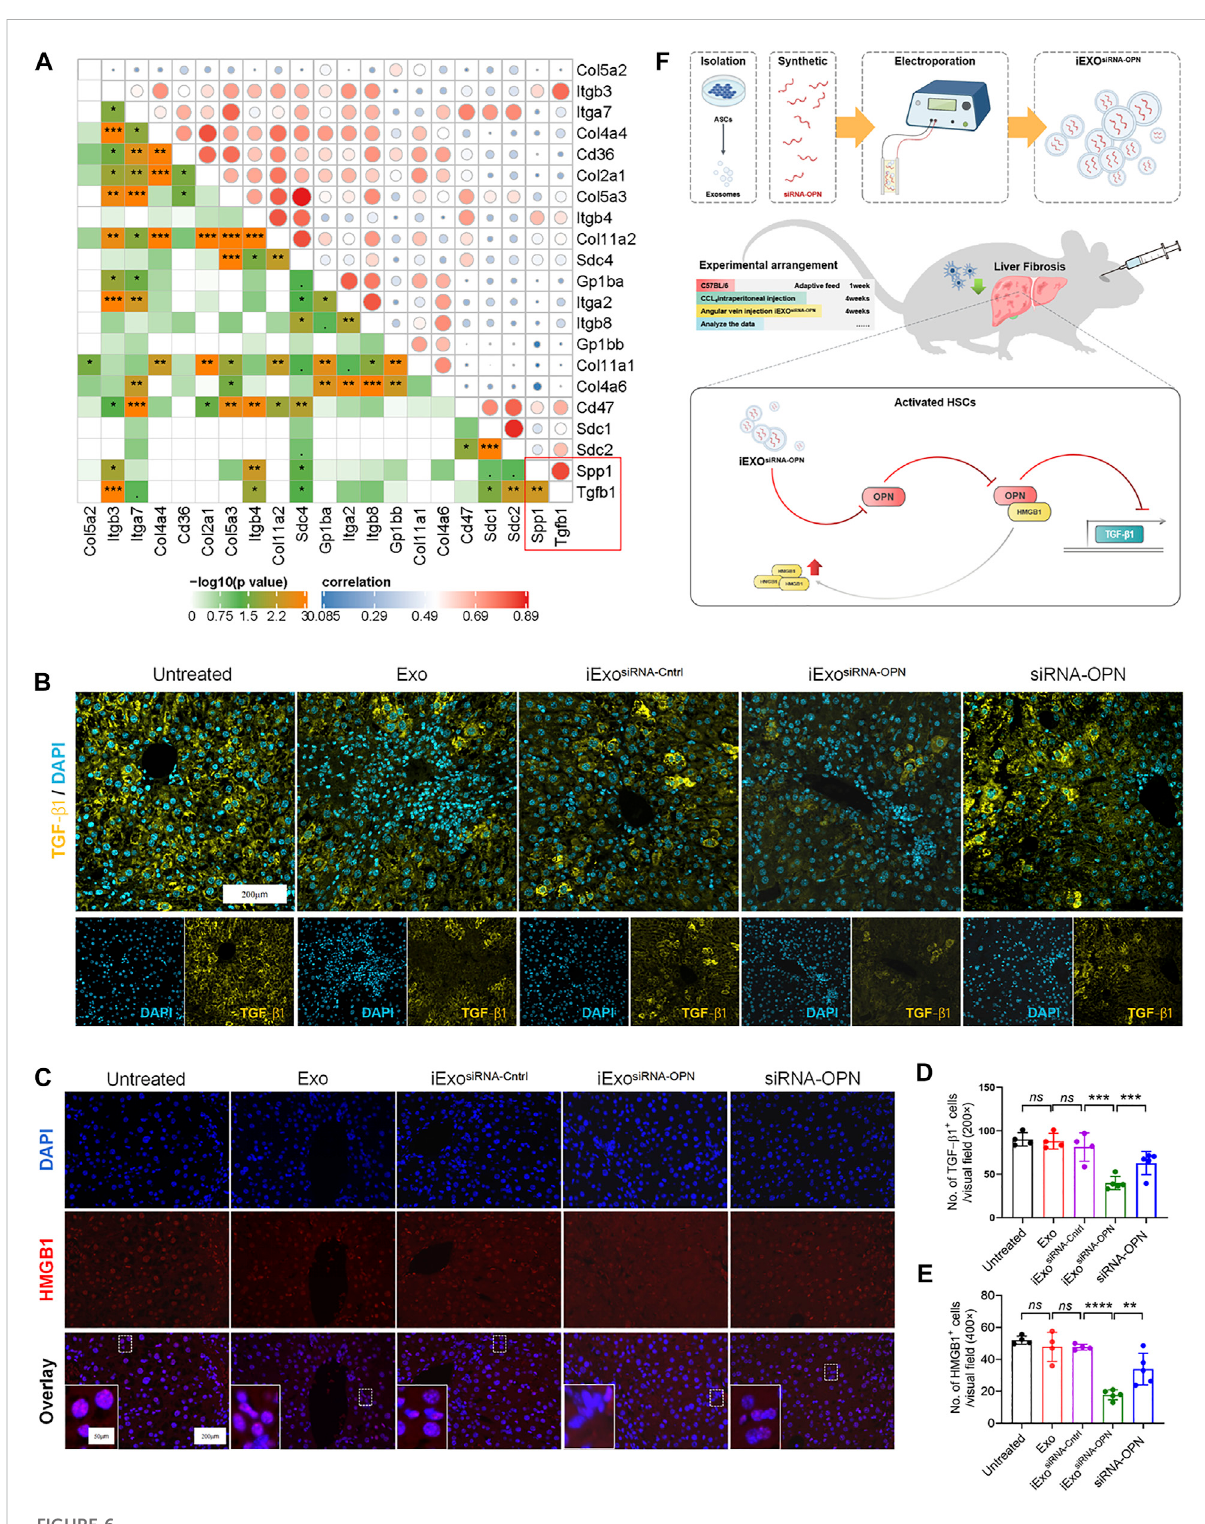
FIGURE 6 iExosomes targeting OPN induced TGF- β 1 signaling via HMGB1 activation. (A) Correlation between OPN and selected ECM-related genes. (B,D) TGF − β 1 IF staining of the listed groups and number of TGF − β 1 positive cells in each visual fi eld. Untreated, Exo, and iExo siRNA − Cntrl : n = 4 mice per group; iExo siRNA − OPN , siRNA-OPN: n = 5. (C,E) HMGB1 IF staining of liver section in each group and average number of HMGB1 positive cells in each visual fi eld. Untreated, Exo, and iExo siRNA − Cntrl : n = 4 mice per group; iExo siRNA − OPN , siRNA-OPN: n = 5. (F) Potential working model of iExo siRNA − OPN inhibiting HSCs activation and attenuating liver fi brosis progression. The data are expressed as Sidak ’ s post – hoc analysis. P < 0.001 ***, p < 0.01